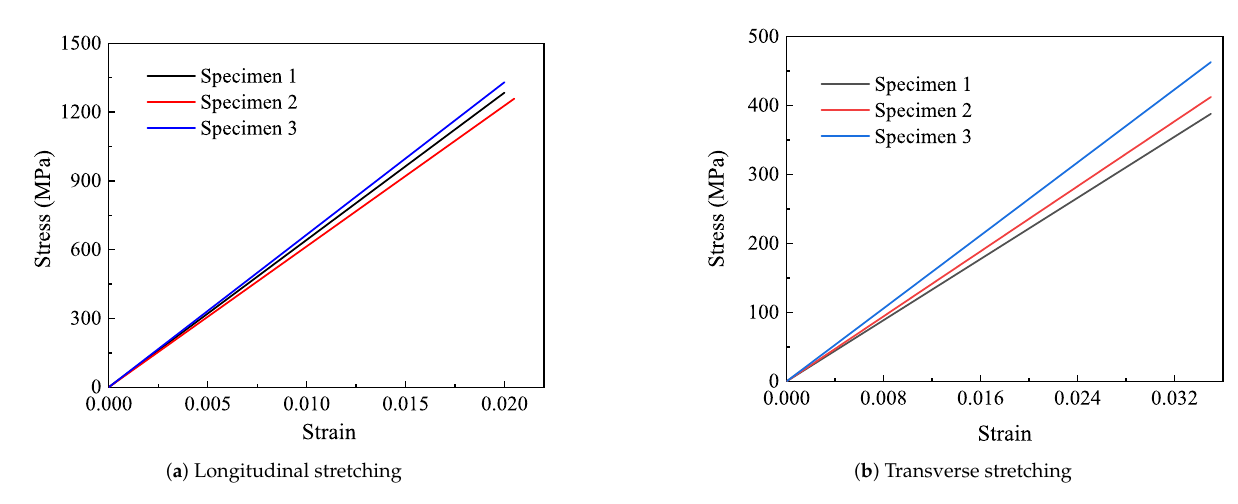
Figure 16. Stress–strain